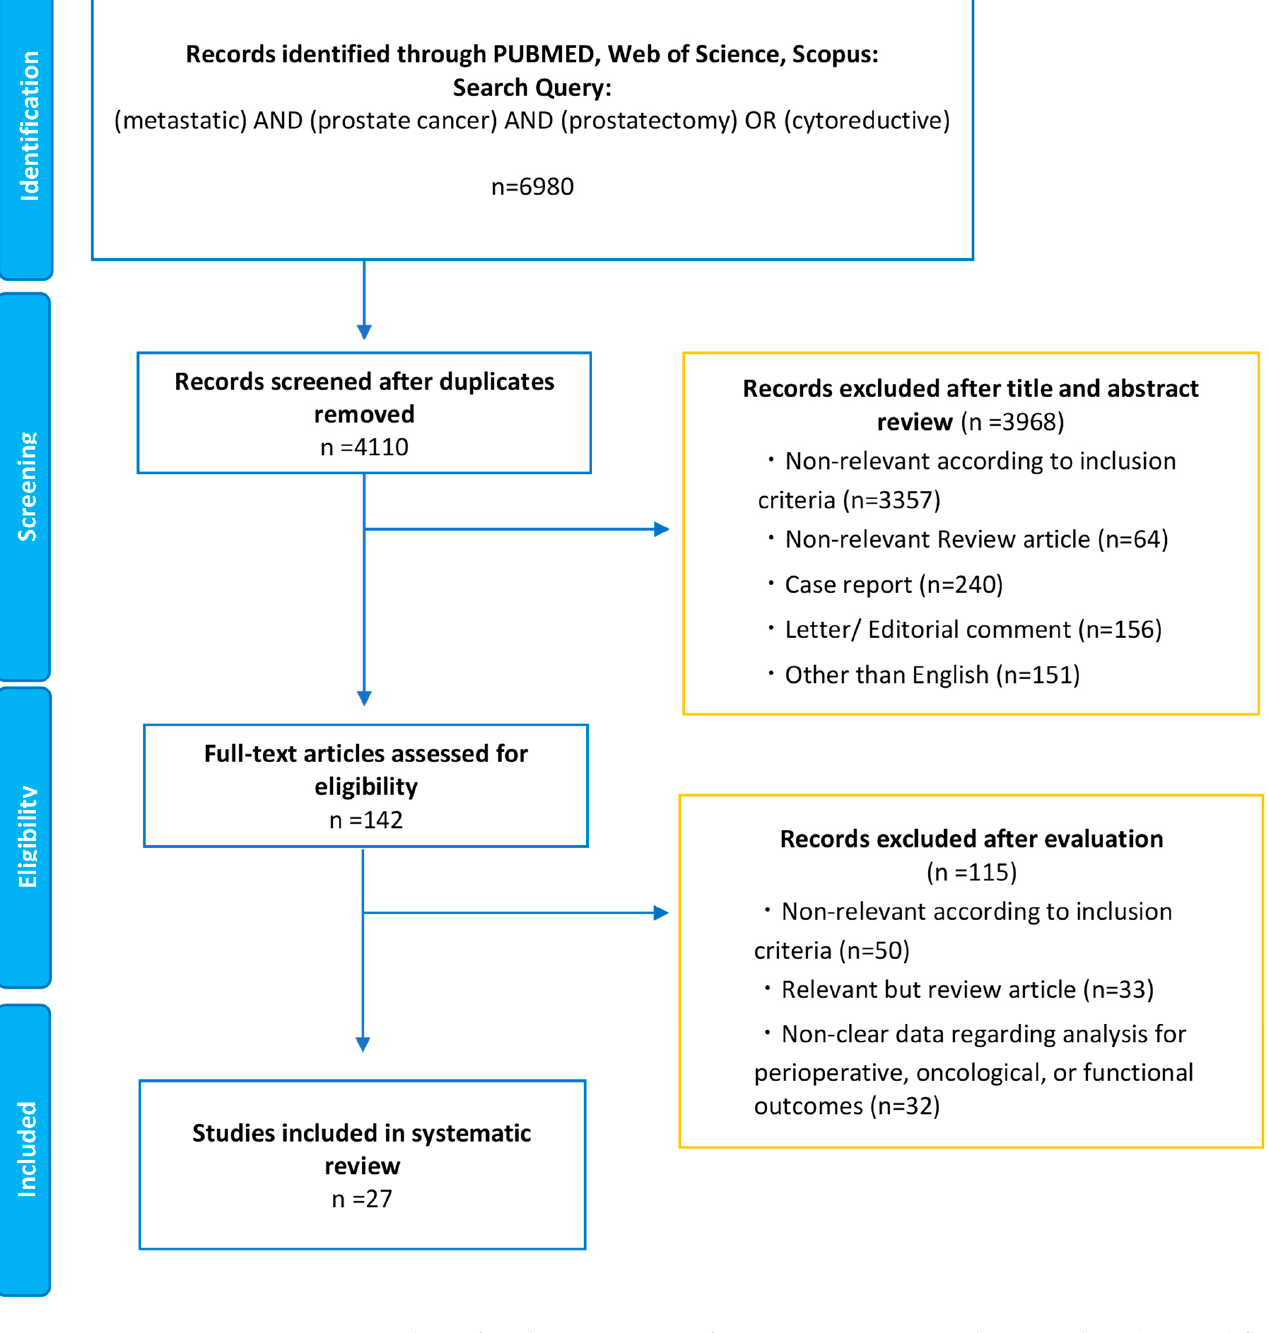
Figure 1. The Preferred Reporting Items for Systematic Reviews and Meta-analyses (PRISMA) flow chart, detailing the article-selection process.